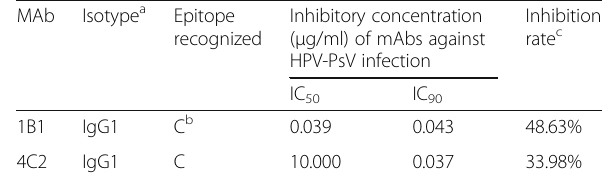
Table 1 Characteristics of the HPV18-VLP mAbs MAb